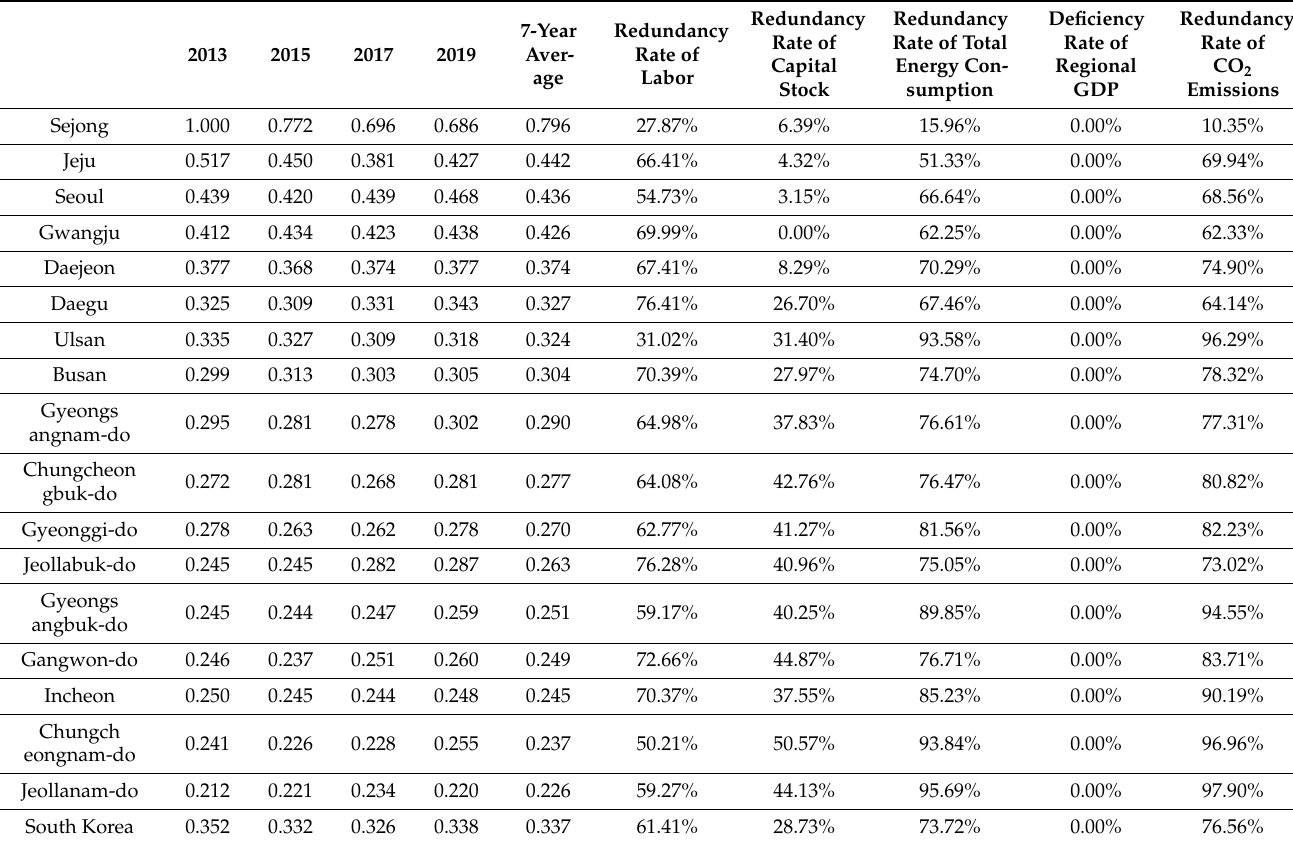
Table 7. Evaluation results of low carbon economic efficiency value in South Korea from 2013 to